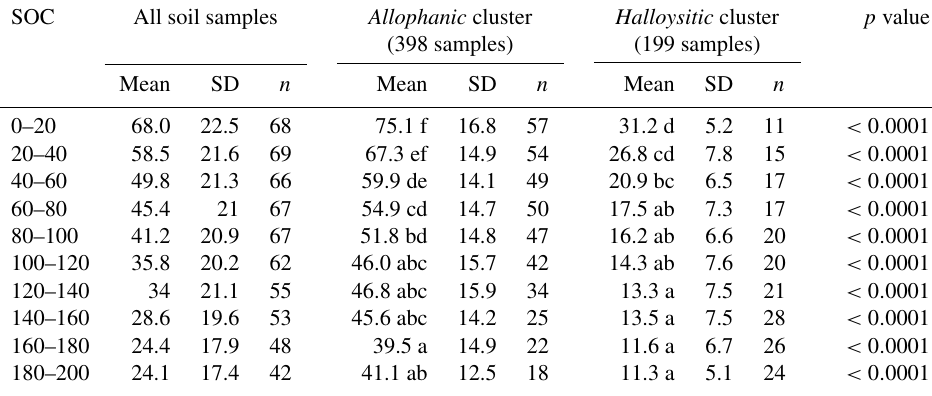
Table 4. Descriptive statistics for SOC contents (gkg − 1 soil) of all soil samples with depth, and with their spectral cluster; p value expresses results from the t test between samples from the two spectra cluster classes (Welsh, two-sided alternative). For a given cluster, means followed by the same letters do not differ significantly at p = 0 . 05. SOC All soil samples Allophanic cluster